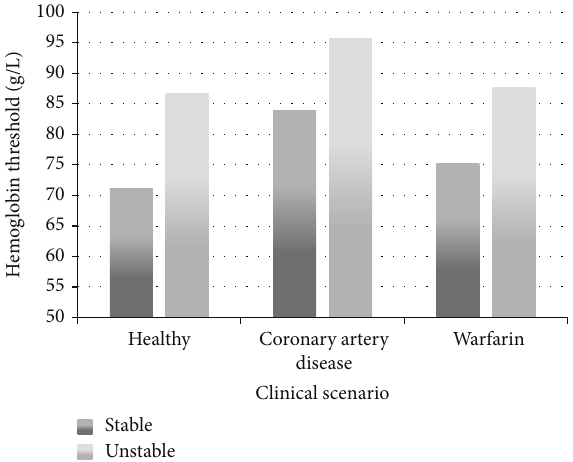
Figure 4: Mean hemoglobin transfusion threshold by clinical